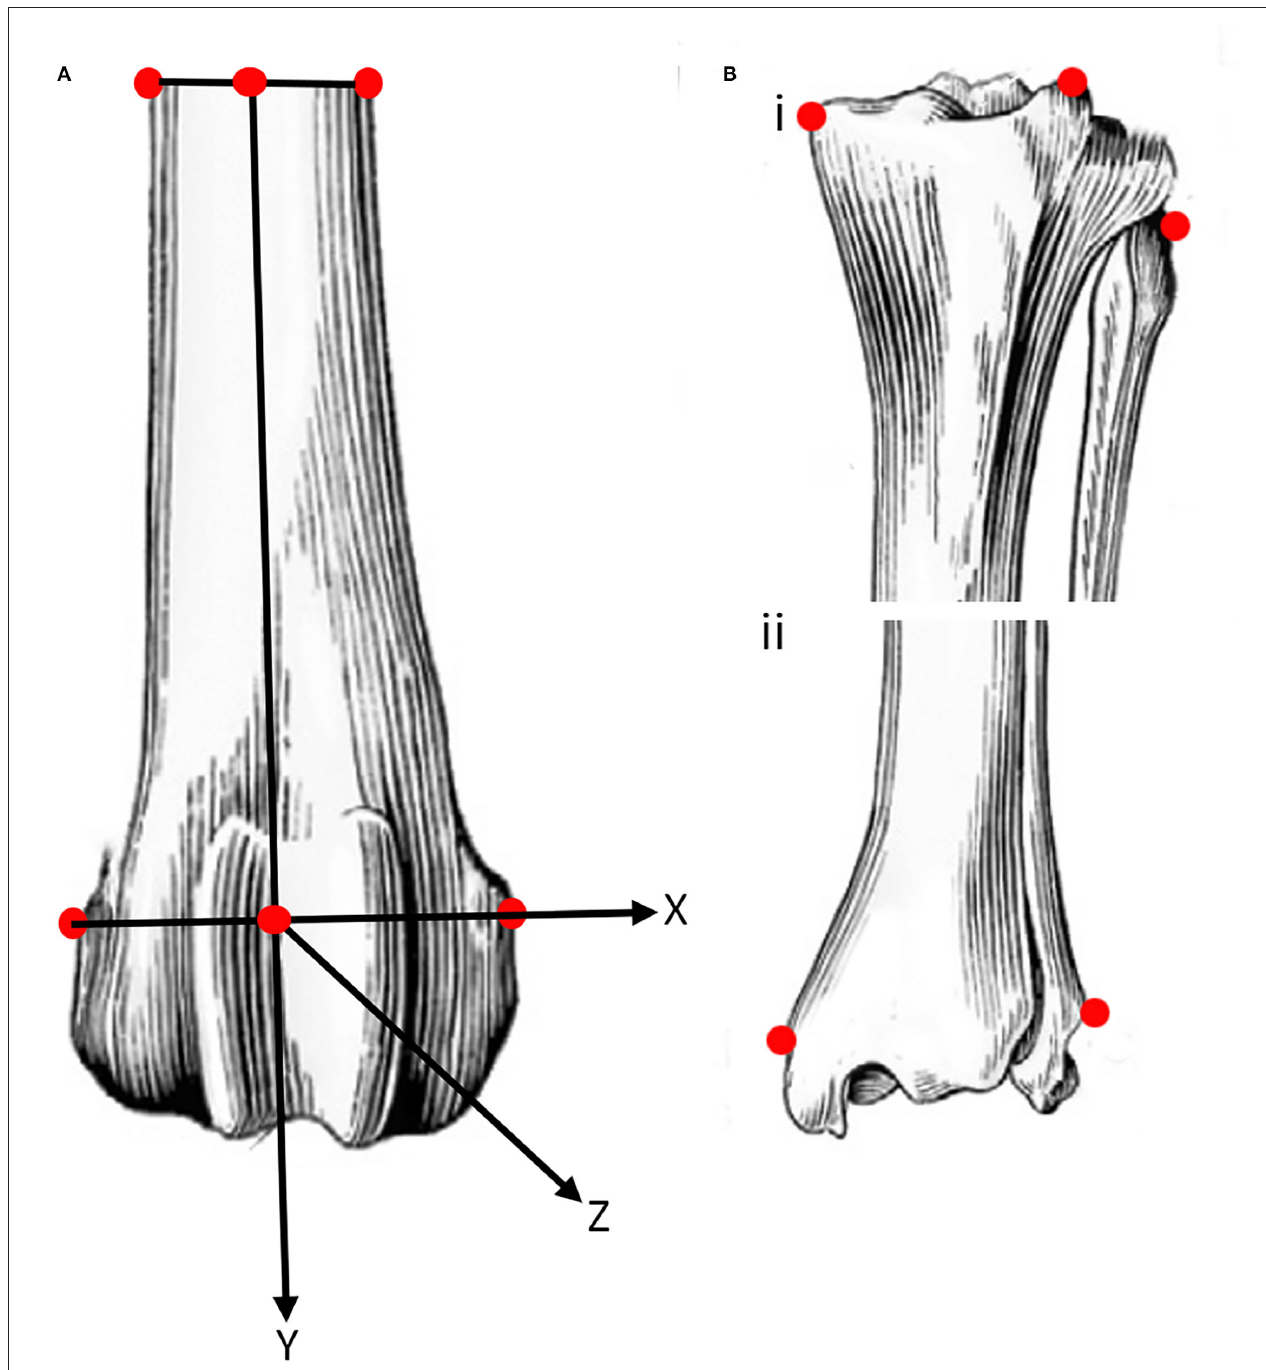
FIGURE 2 | Schematic representation of the location (see text for details) of points of interest (POI) on easily identifiable prominent landmarks on the femur (A) , and proximal (B i ) and distal (B ii ) tibia and fibula. The POI of the femur were used to define a system of axes embedded in the femur with the origin midway between the points of interest on the distal femur. The POI on the caudal aspect of the tibia at the attachment of the sensor is not